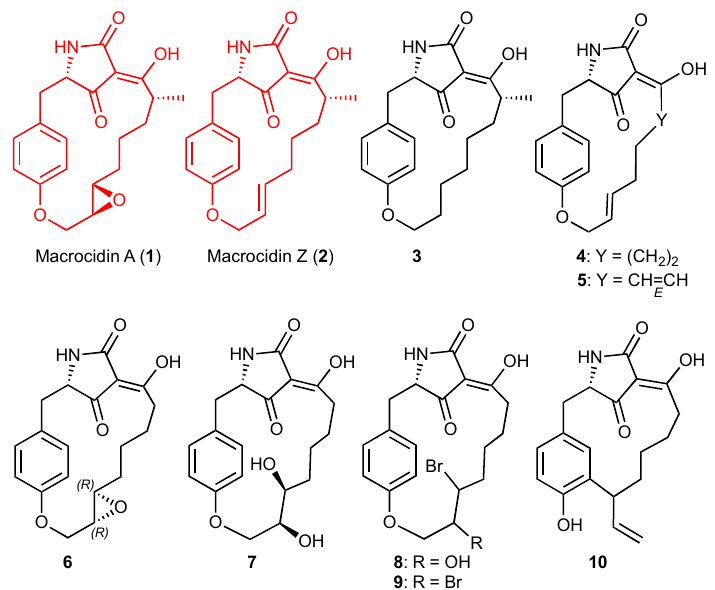
Figure 1. Structures of the natural lead compounds macrocidin A ( 1 ) and macrocidin Z ( 2 ) and structural variants 3 – 10 .